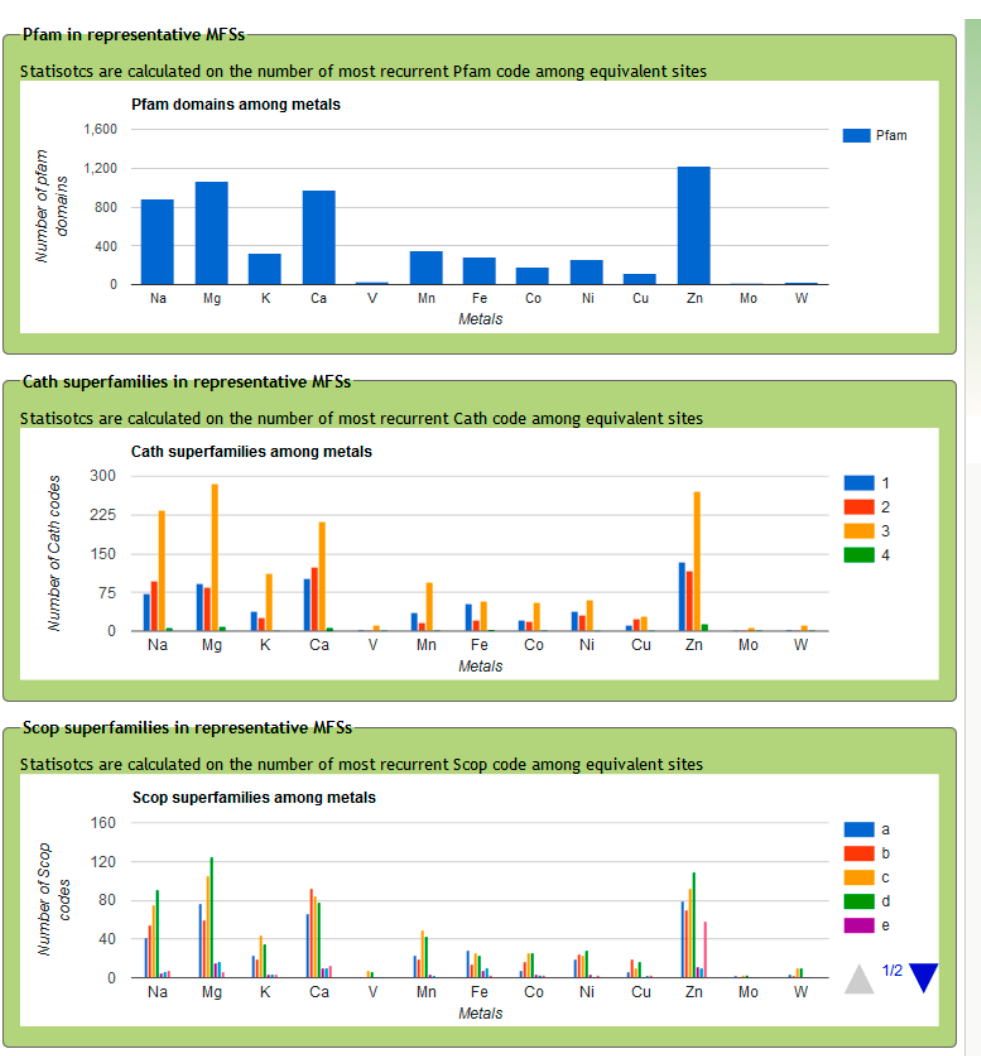
Figure 4. Number of different Pfam domains, CATH and SCOP superfamilies associated to each metal in MetalPDB. CATH and SCOP superfamilies are separated by Class (as an example, class 1 in CATH corresponds to mainly helical proteins).